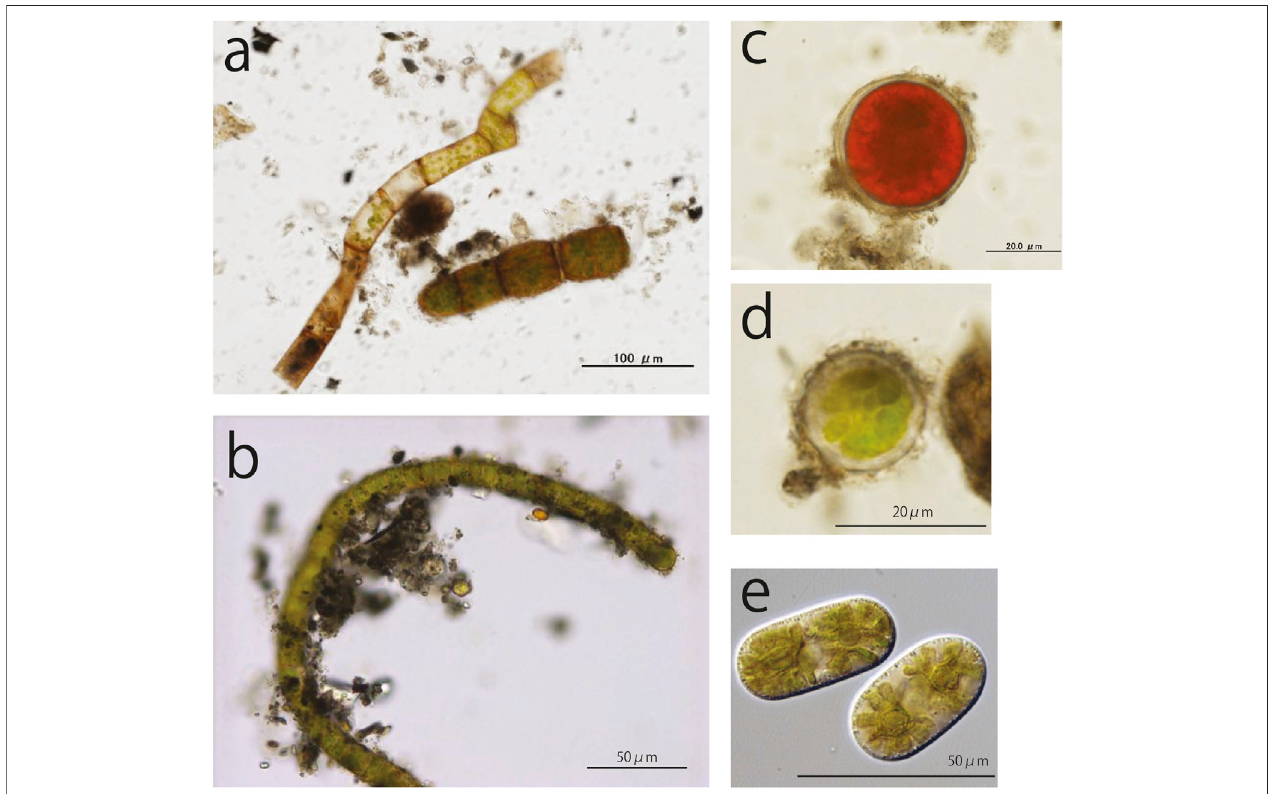
FIGURE 5 | Phototrophs (moss gemma and Chlorophyta) on Stanley Glacier surface: (A) Celatodon purpureus, (B) unidenti fi ed green algae, (C) snow red algae, (D) unidenti fi ed round, green algae, (E) Cylindrocystis brebissonii.